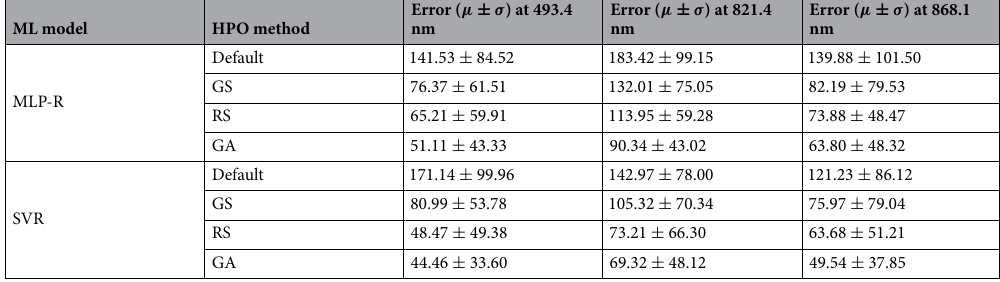
Table 4. Estimation error for predicting soil